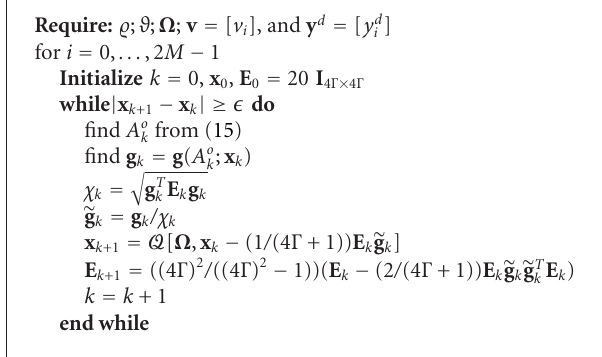
Algorithm 1: Iterative calculation of the filter coe ffi cients